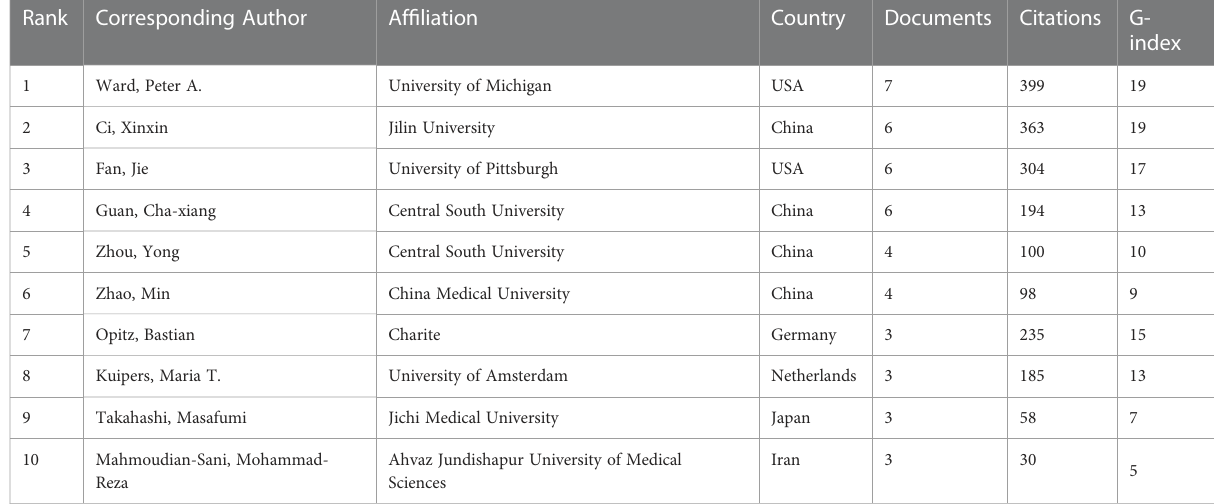
TABLE 3 The top 10 productive corresponding